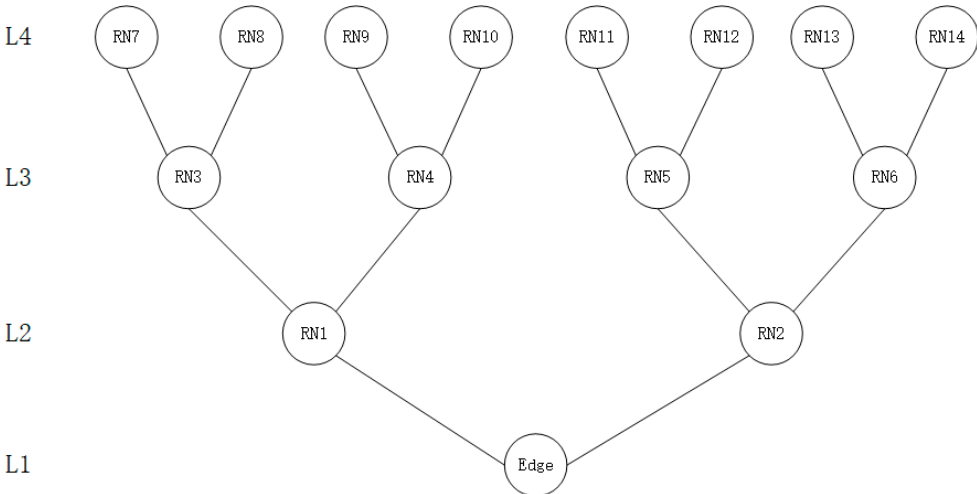
Figure 4. Experimental Scenario 1 topology (Black dots represent replica nodes RN3 to RN14).